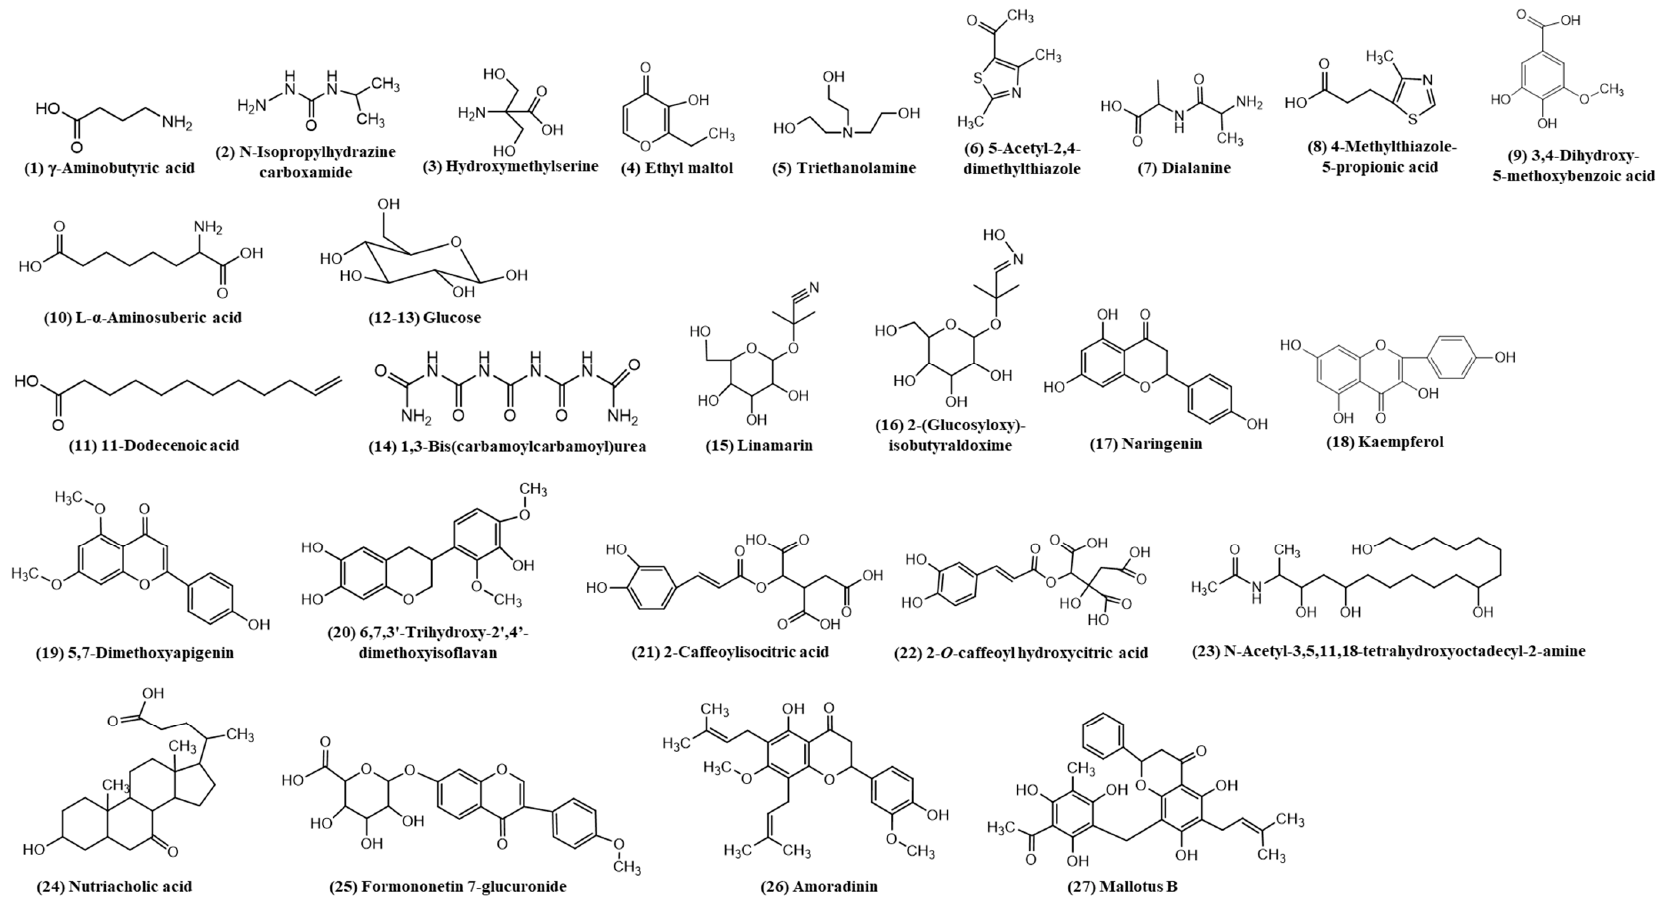
Figure 2. Chemical structures of the identified compounds of DIBEt by PSI-MS/MS.